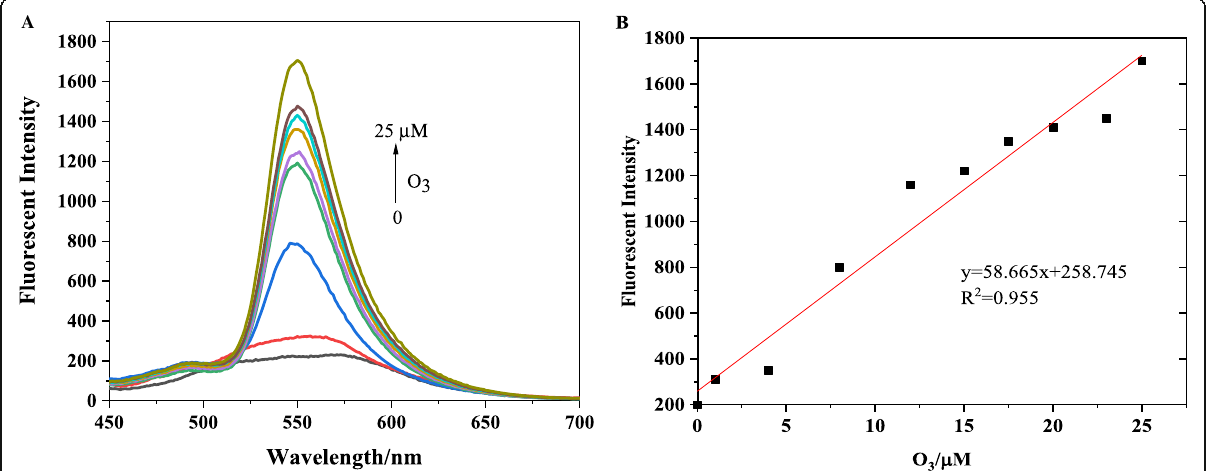
Fig. 3 Fluorescence spectrum change curve. a The spectrum of probe BCT (10 μ M) when different concentrations of O 3 aqueous solution were added to PBS buffer (pH =7.4, 10 mM). b Linearly fit the fluorescence spectrum and calculate its minimum detection limit